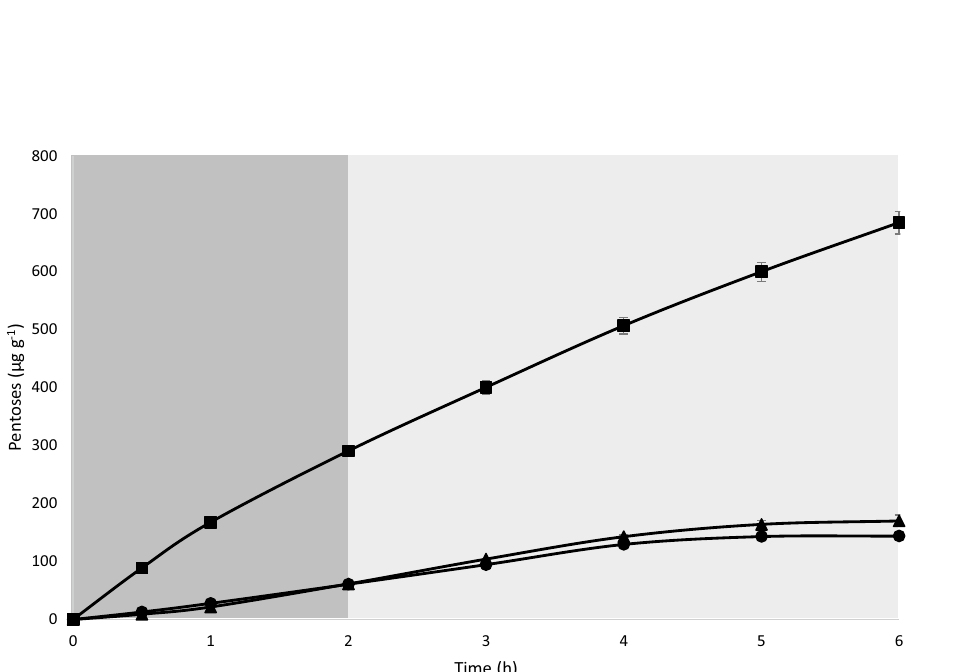
Figure 3. Pentoses release (µg g −1 of diet) from BSG0.4 diet with inactivate fish enzymes (filled black square), inactive BSG 0.4 diet with active fish enzymes (filled black triangle) and both inactive BSG 0.4 diet and fish enzymes (filled black cirle), under the simulated conditions of European seabass digestive tract. Stomach and intestinal digestion are represented in dark and light grey, respectively. Values are presented as the mean of the cumulative values ± standard